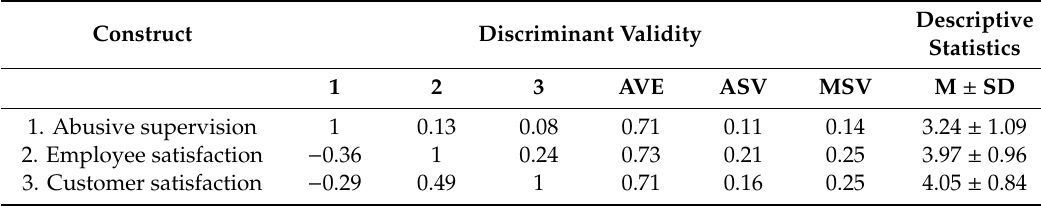
Table 3. Correlations among the latent constructs.